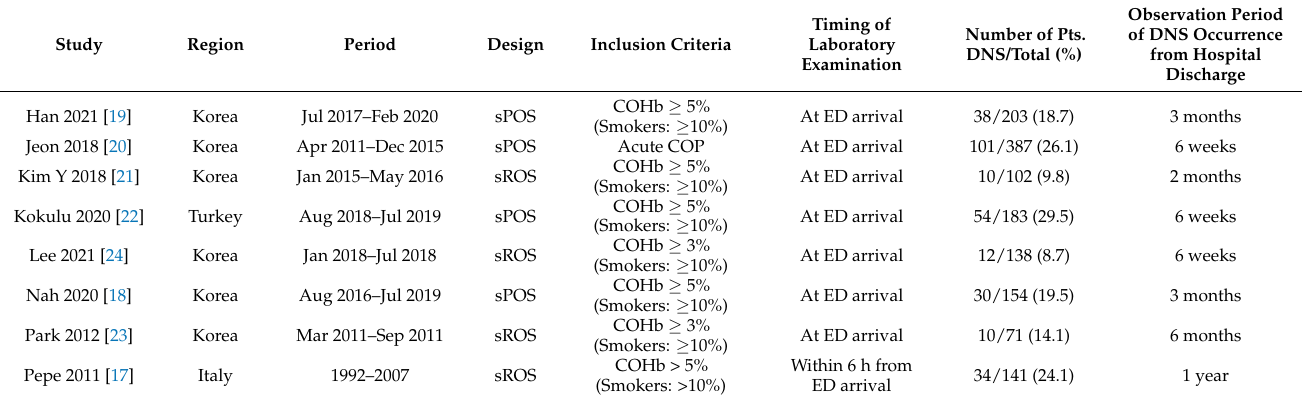
Table 1. Study characteristics included in the meta-analysis.